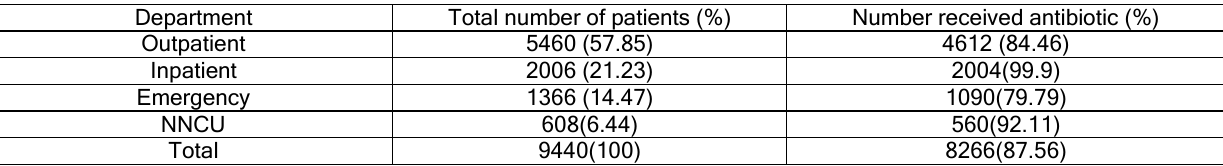
Table 2: Overall antibiotics prescribed in different Department.